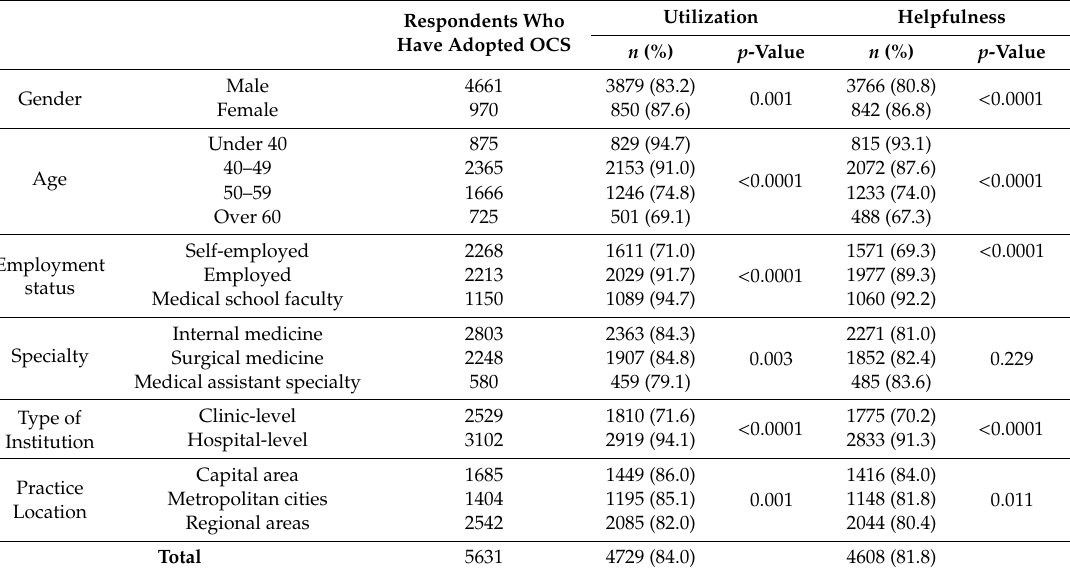
Table 3. Factors related with the utilization and helpfulness of